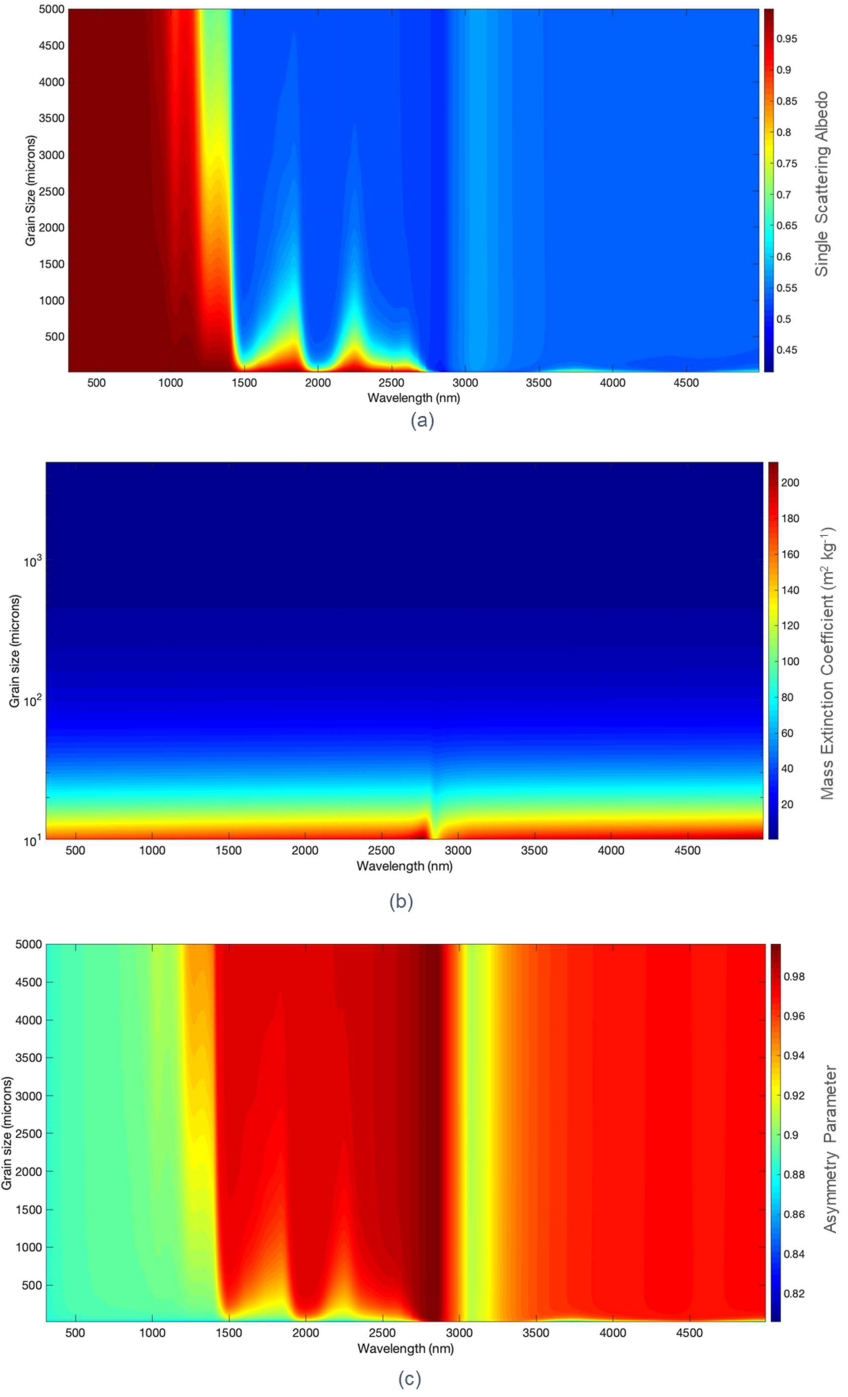
Figure 1. Optical properties of ice, as calculated from Mie theory, across the range of wavelengths (300–5000 nm) and e ff ective grain radii (10–5000 µ m) available in Snow, Ice, and Aerosol Radiation (SNICAR). ( a ) The single-scattering albedo is near unity across all grain radii in the visible and near-visible wavelength range. ( b ) The mass extinction coe ffi cient is nearly uniform over most of the wavelength and e ff ective grain radius range. Note that the vertical axis uses a log-scale to highlight changes in MEC for small grain radii ( < 100 µ m). ( c ) The large asymmetry parameter, g ( ≈ 1), indicates mostly forward scattering across all wavelengths and e ff ective grain radii, as expected for sizes much larger than the